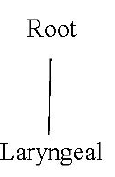
Figure 14. Feature geometry of French /h/.